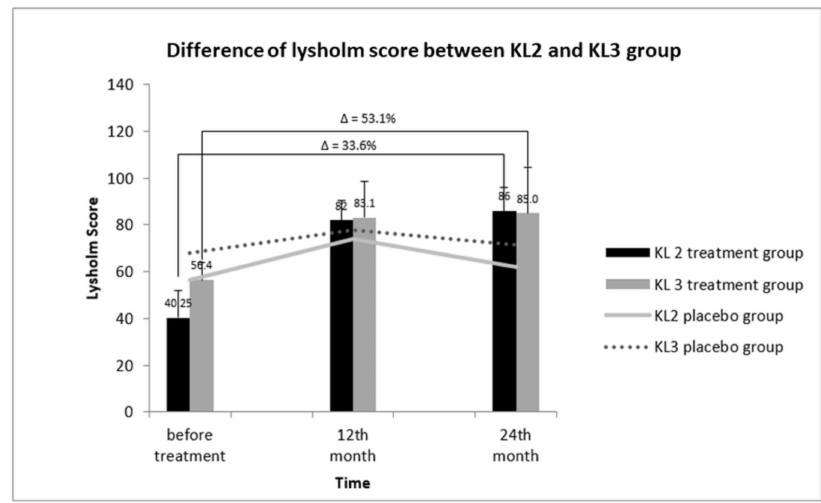
Figure 6. Lysholm scores of KL-grade 2 and 3 patients after SVF therapy at 12 and 24 months. After 24 months of treatment. The increase of the Lysholm score in KL-grade 3 patients was comparatively greater than that in KL-grade 2 patients (33.6%. vs. 53.1%). ∆ : percentage of improvement in lysholm